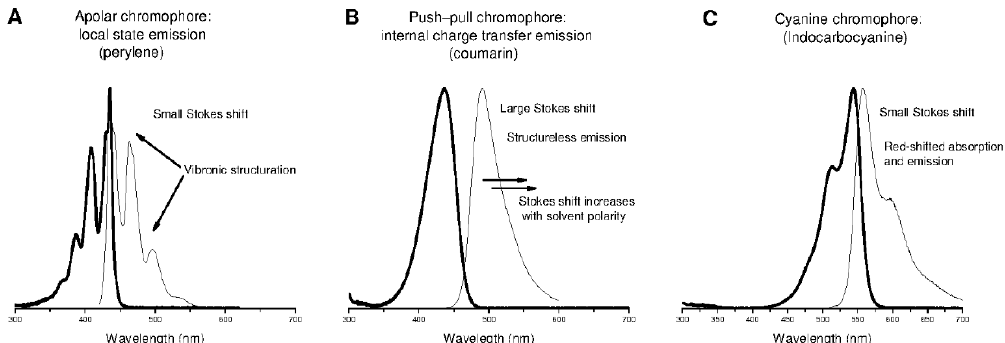
Figure 3. General trend of absorption and emission of three chromophore families. ( A ) Apolar chromophores; ( B ) Push–pull chromophores; ( C ) Cyanine chromophores. (Spectra extracted from photochemCAD) [45].